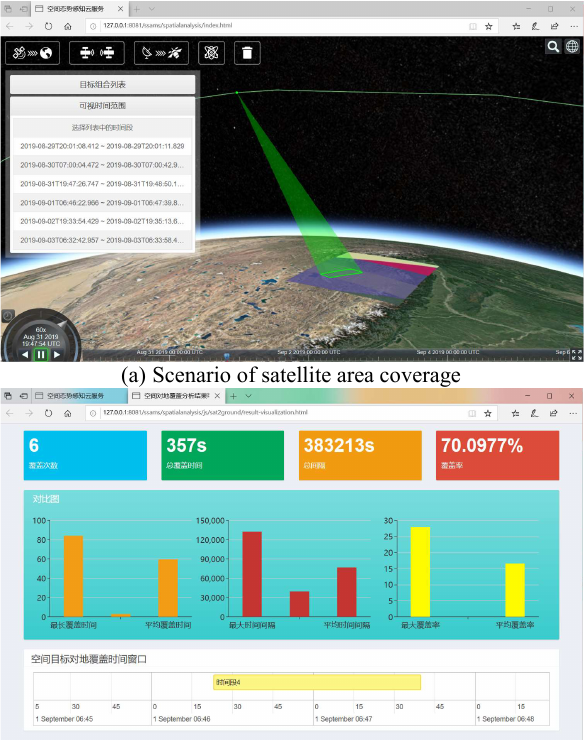
Figure 8. Visualization of scenarios and